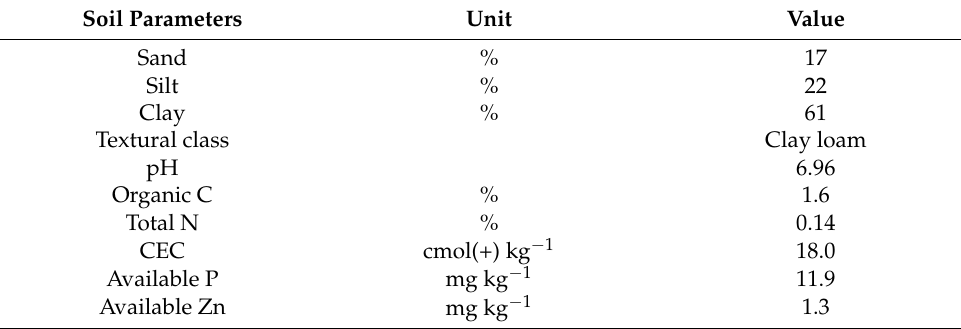
Table 4. Physicochemical properties of the experimental site’s soil.